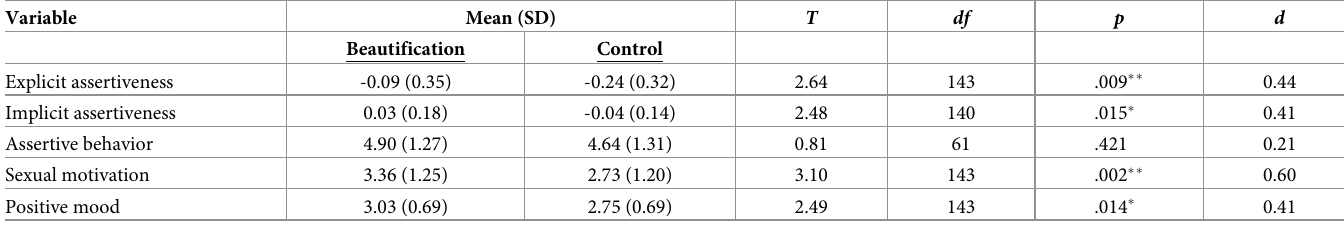
Table 1. Differences between control and beautification conditions on the dependent variables in Experiment